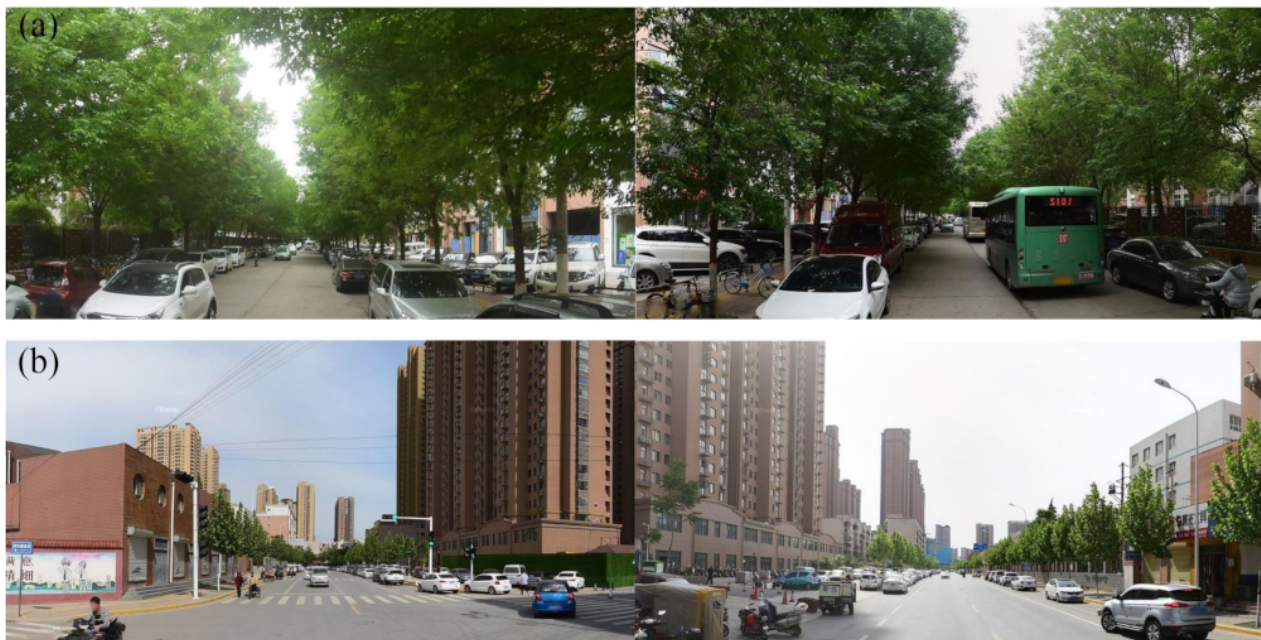
Figure 7. Street view (( a ) old city; ( b ) new development